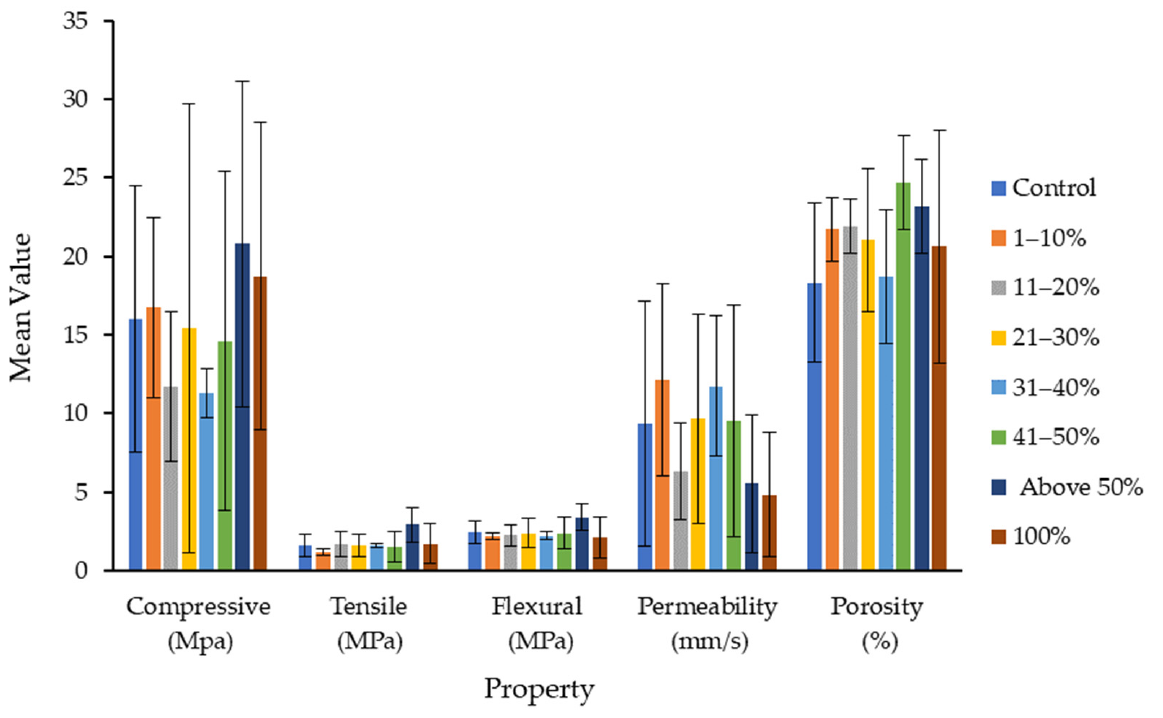
Figure 10. Mechanical and durability properties as a function of the aggregate replacement percent- age.